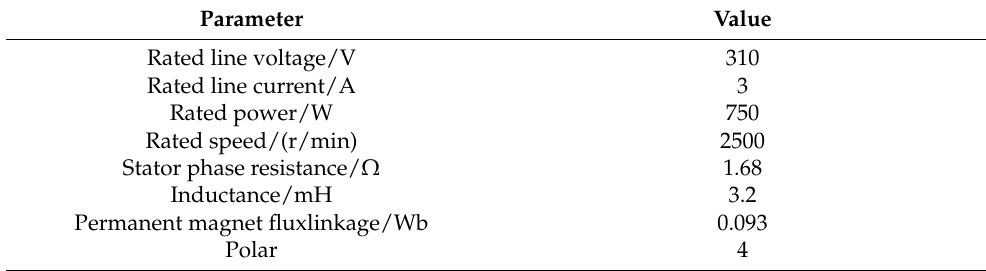
Table 1. Parameters of simulated motor.